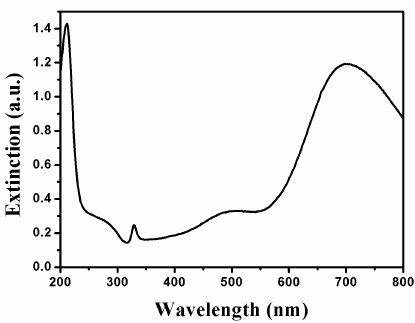
Figure 1. UV-vis extinction spectrum recorded for Ag triangular nanoprisms synthesized by the photoinduced conversion approach.